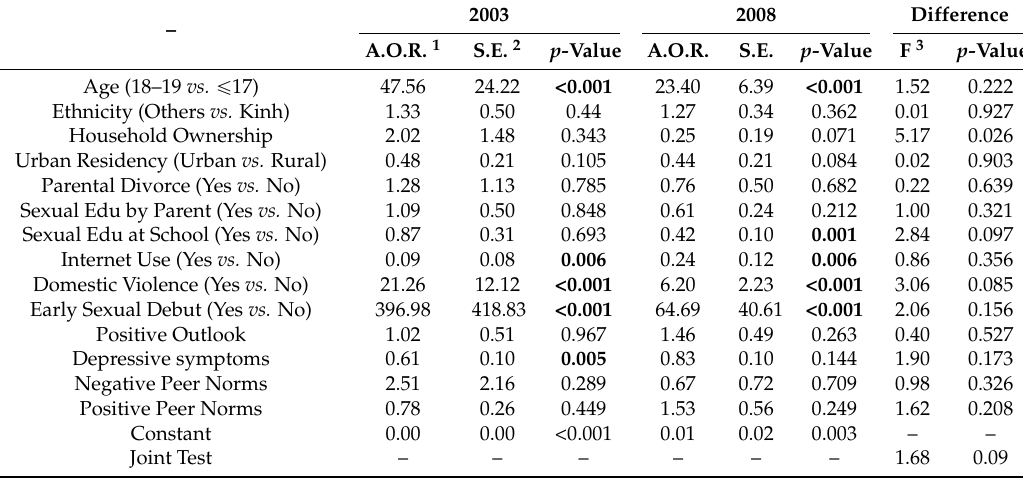
Table 3. Logistic regression with teenage pregnancy in Vietnam as the outcome (2003 vs.